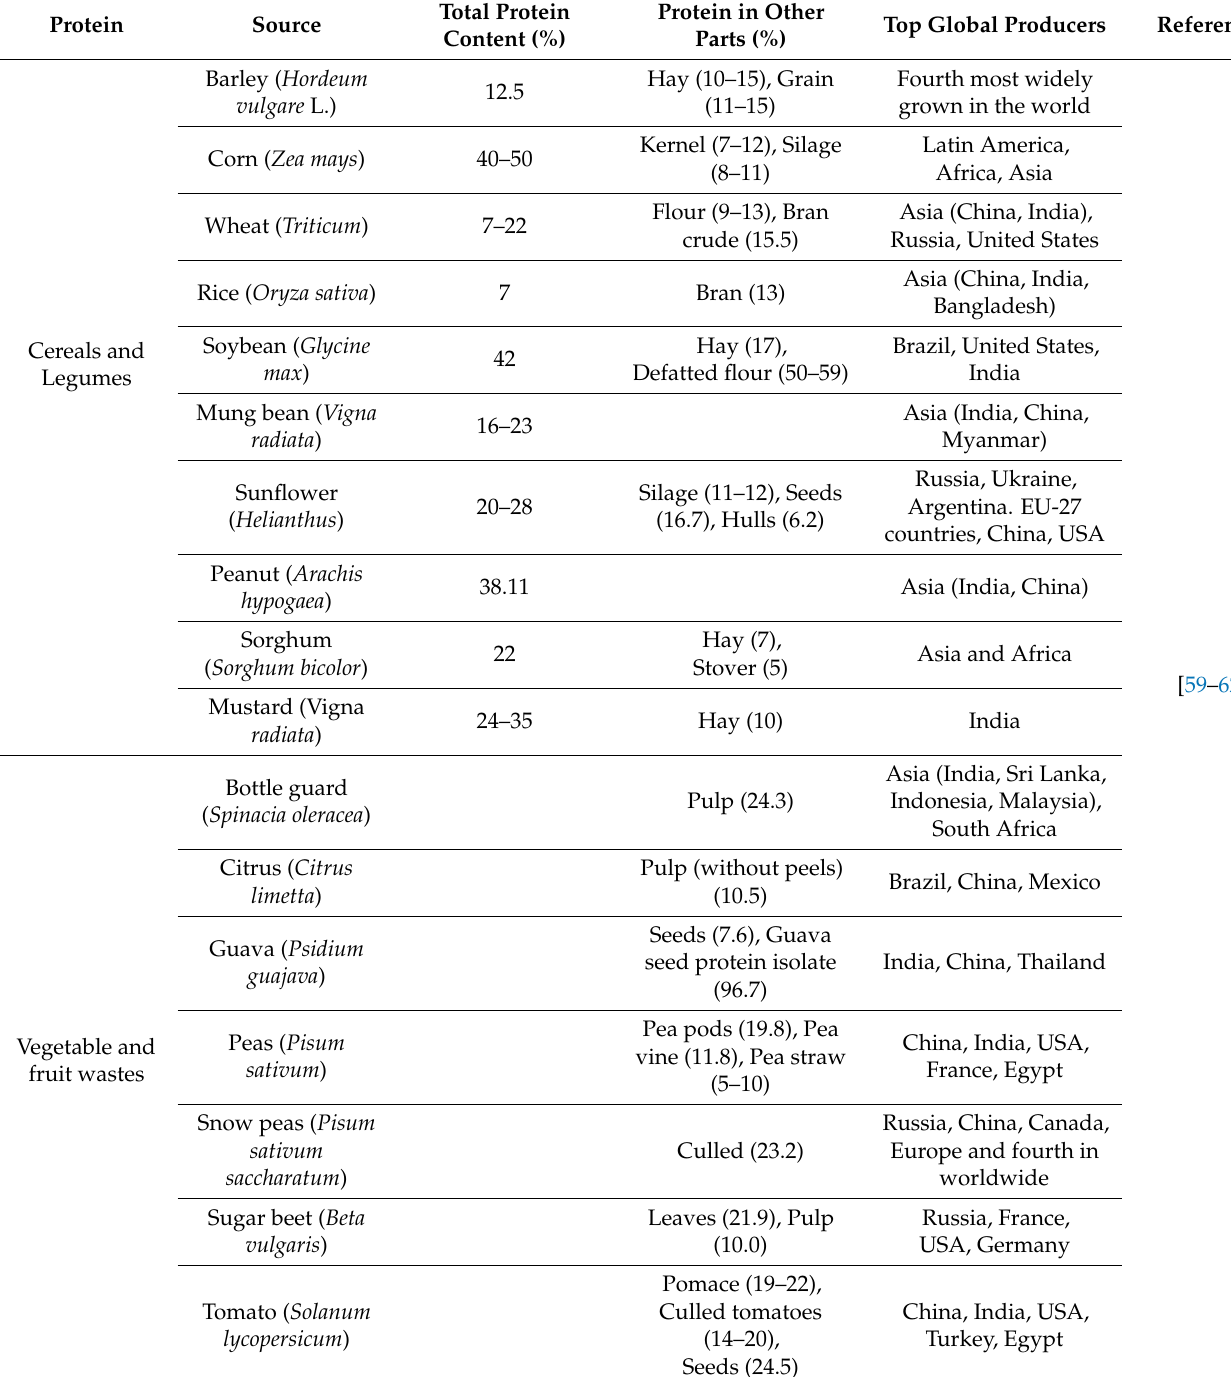
Table 2. Protein sources with the total protein content, their distribution and top global